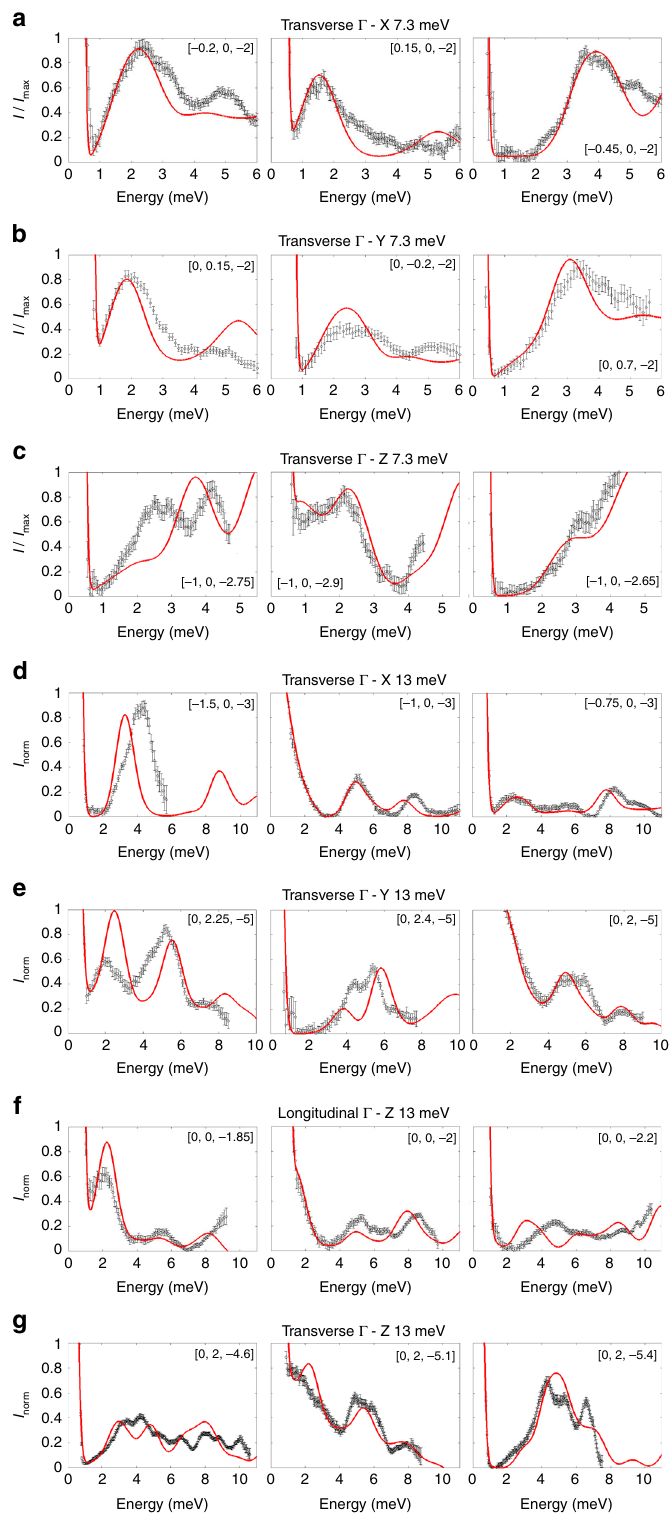
Fig. 2 Phononic excitations intensities vs energy. Black scatters: Representative examples of [VO(acac) 2 ] phononic excitations as a function of energy, obtained from LET data with E i = 7.3 meV ( a – c ) and E i = 13 meV ( d – g ) at T = 5 K. The 1D cuts have been obtained by integrating the 4D datasets over the three components of the neutron scattering vector Q ¼ ½ η ; ζ ; ξ (cid:2) (expressed in terms of reciprocal lattice vector units) around the desired values, with error bars representing the SE. For data obtained with E i = 7.3 meV the intensity is normalised for the maximum in each panel, while for data obtained with E i = 13 meV the intensity is normalised in order to saturate acoustic modes and give prominence to optical ones. Red lines: intensity curves as a function of energy calculated with Eq. (3) (see Methods) and with phonon energies and polarisation vectors obtained from DFT.